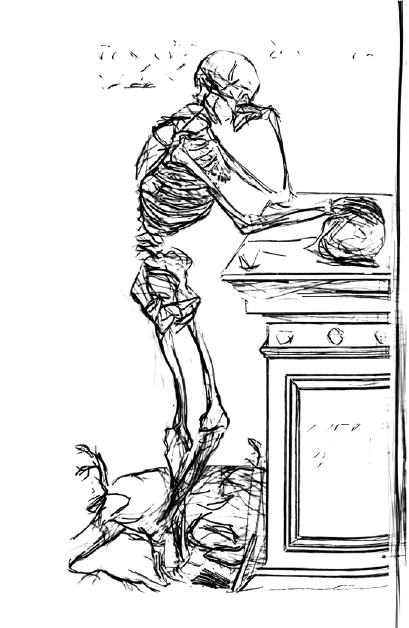
Fig. 2 - Cover of his work De Humani Corporis Fabrica (Adapted [11] ).